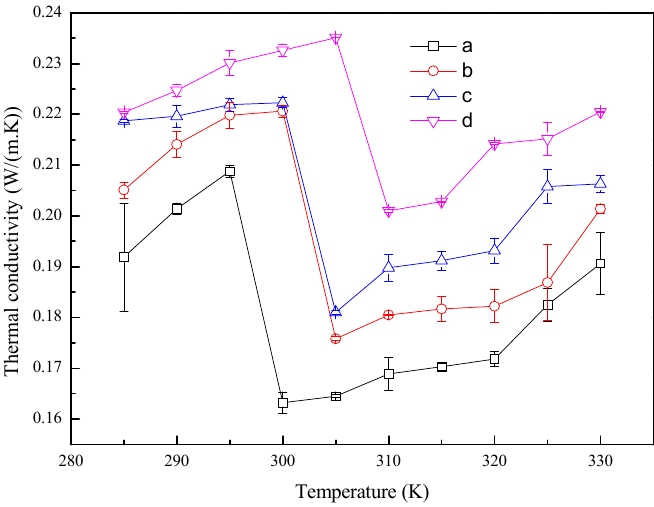
Figure 10. Thermal conductivities of the n -octadecane/Cu nanoparticle nanofluids with different temperatures. ( a ) 128 n -octadecane molecules; ( b ) 1 Cu nanoparticle and 512 n -octadecane molecules; ( c ) 1 Cu nanoparticle and 256 n -octadecane molecules; ( d ) 1 Cu nanoparticle and 128 n -octadecane molecules;